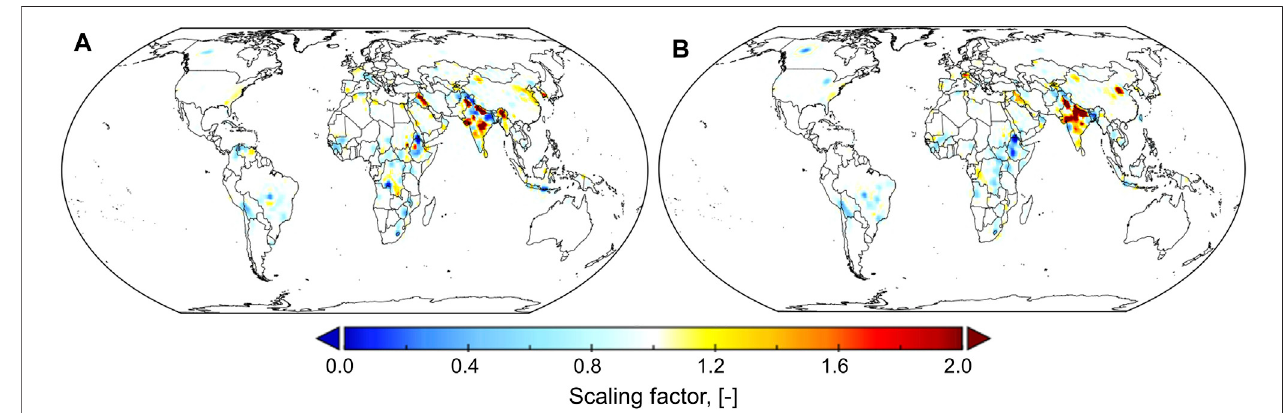
FIGURE 5 | Relative difference (model-observation) in CO concentration between IFS analysis and aircraft measurements over Atlanta (A) and Mumbai (B) for a reference state-only (blue) and a joint atmosphere/surface-emission analysed state (red).